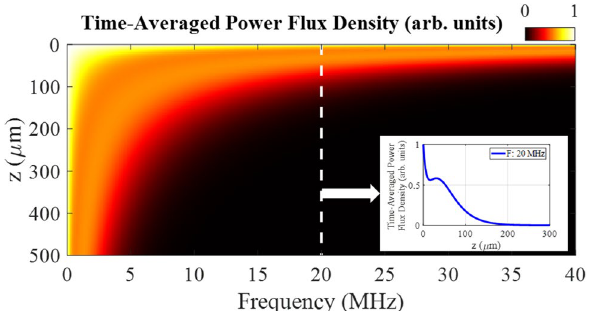
Figure 1. Time-averaged power flux in the direction of wave propagation (x) as a function of frequency and depth into surface (z), using (cid:31) = 129 GPa, µ = 41 GPa, and ρ = 4.42 g/cc. The inset shows the time-averaged power flux at 20 MHz.